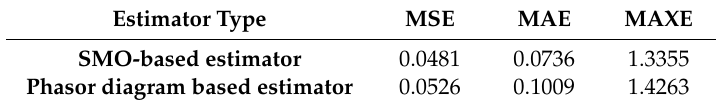
Figure 19. Load angle variation during dynamic disturbances of active power for operating point P = 0.89, Q = 0.11 cap.: ( a ) Comparison of the actual and estimated load angle values; ( b ) Load angle estimation error.